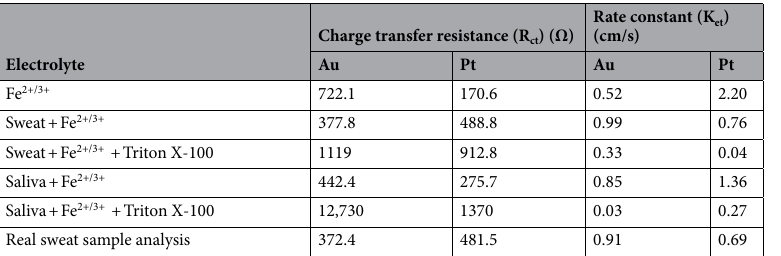
Table 3. Charge transfer resistance (R ct ) and electron transfer rate constant (K et ) values obtained using Au and Pt electrodes studied in artificially simulated sweat and saliva bio-mimic solutions consisting of hexagonal lyotropic liquid crystalline phase (Triton X-100) with Fe 2+/3+ redox